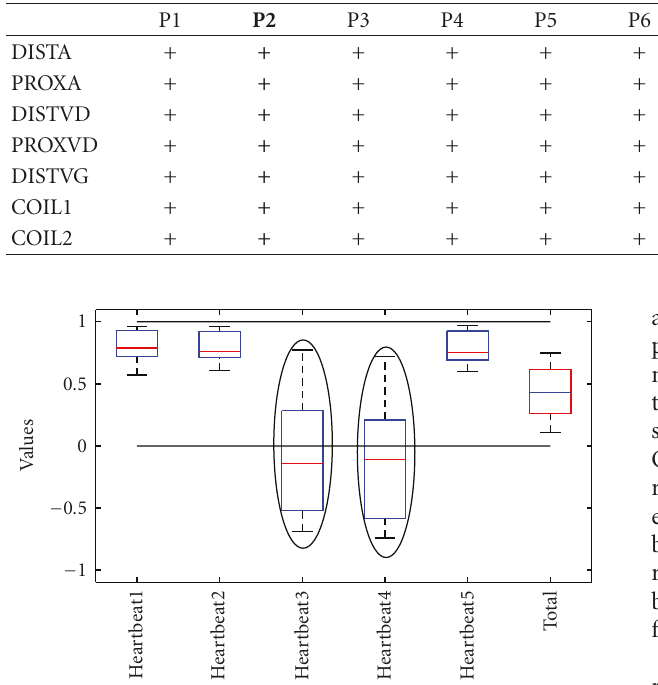
Table 1: For each patient of the database, the number of available EGM electrodes varies from 4 to 7: P2 and P7 (bold case) are the patients with cardiac arrhythmias.